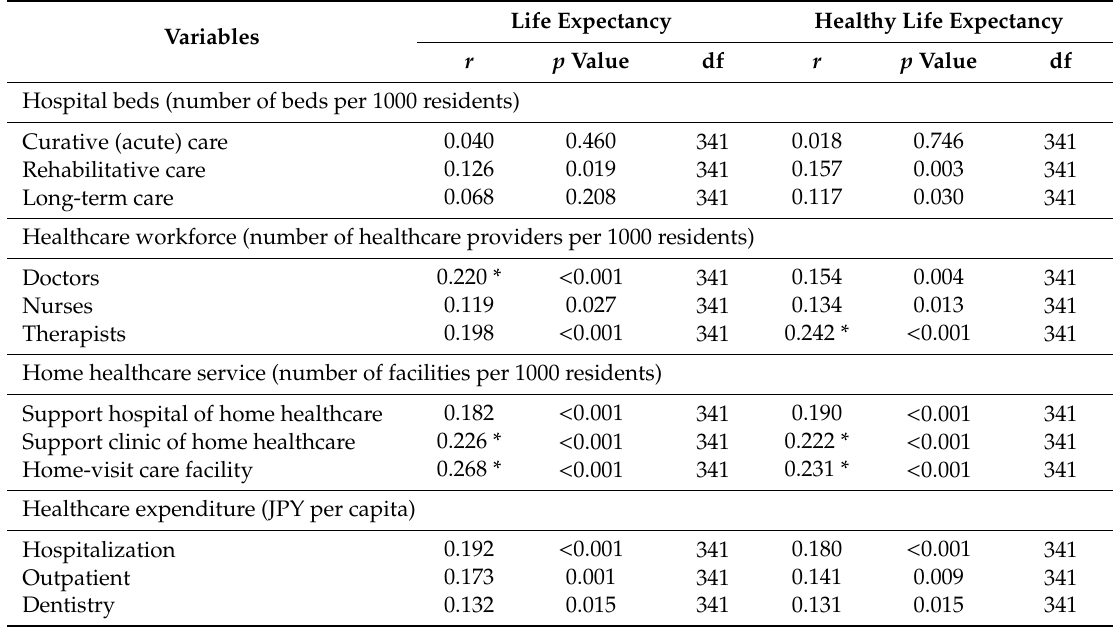
Table 4. Associations between healthcare resources, life expectancy, and healthy life expectancy at birth for